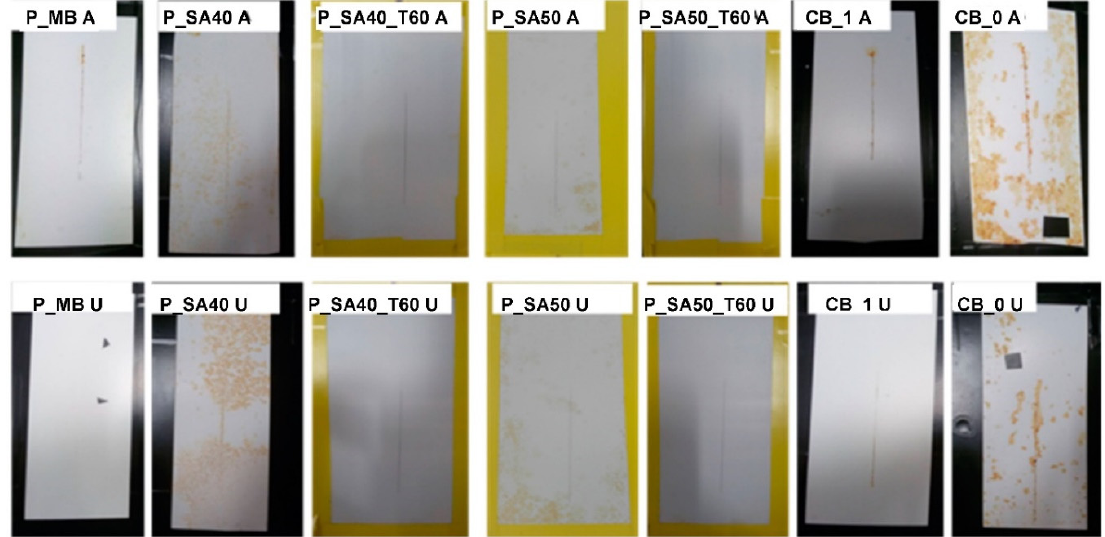
Figure 2. Results of high humidity test for scribed specimens coated with the formulated paints on steel cleaned with the different cleaning procedures (A and U) after 250 h of exposure to RH = 99% and T = 40 °C.